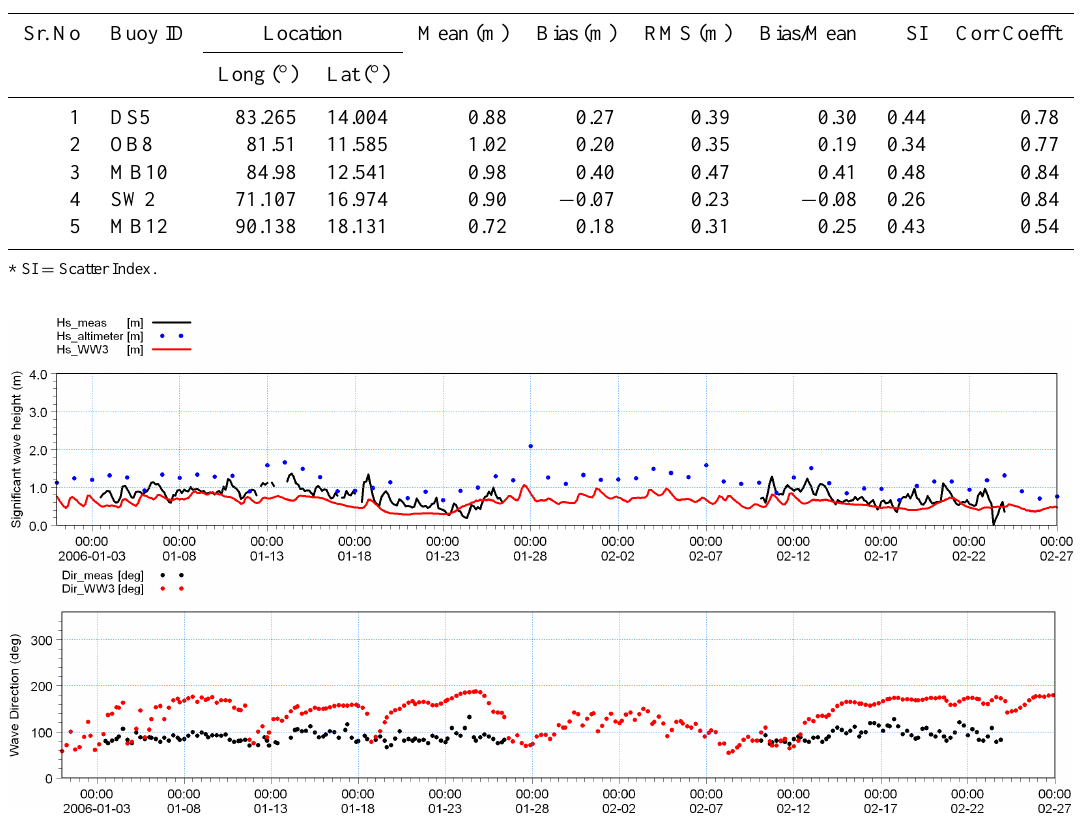
Table 2. Statistical parameters for wave height obtained by comparing model results with altimeter data at the few buoy locations in the Indian Ocean (January–February 2006).